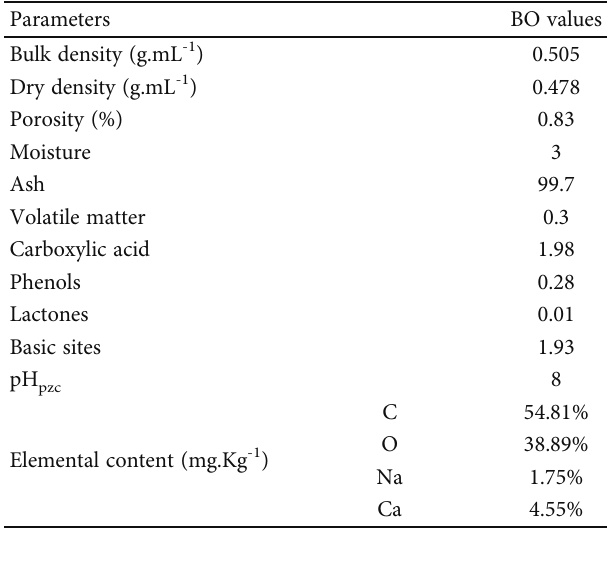
Table 1: Physioanalytical data of Brassica oleracea (BO).